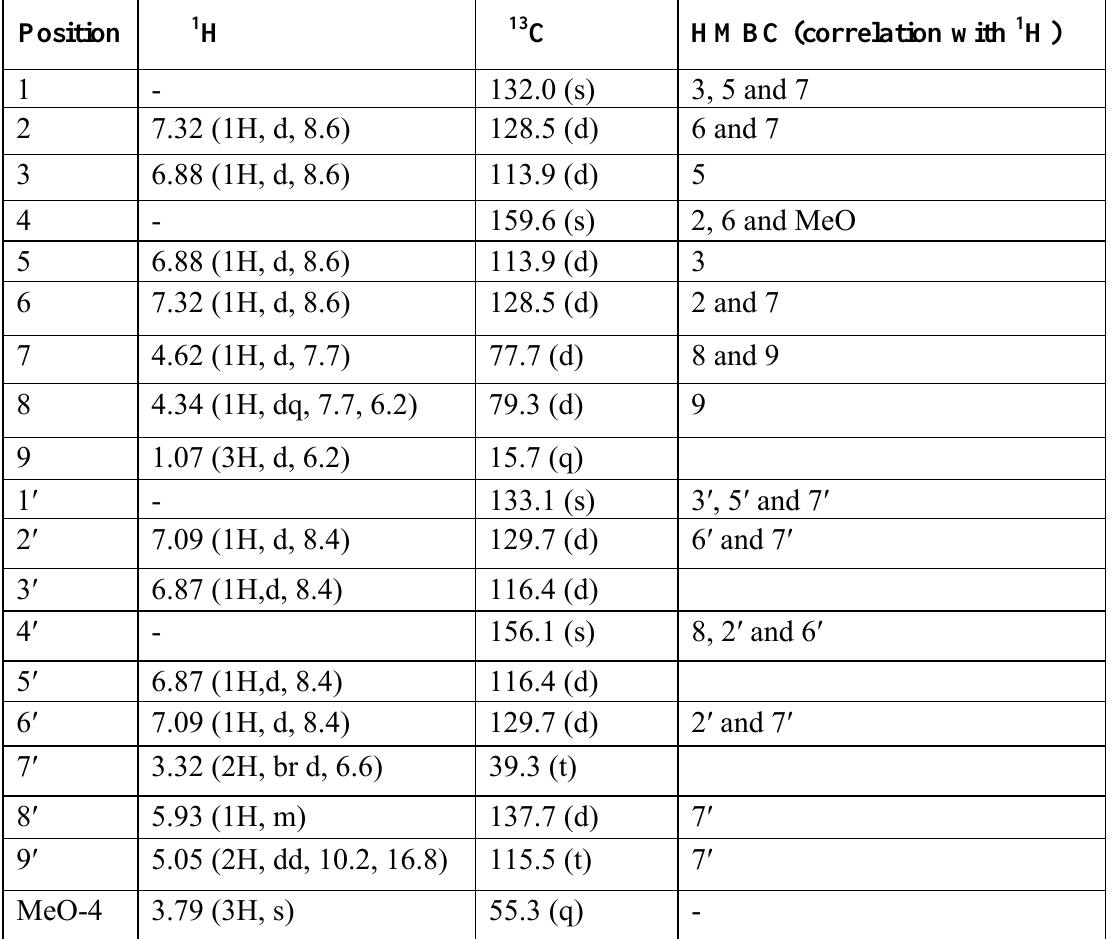
Table 1. 1 H- (300 MHz) and 13 C-NMR (75 MHz) data of 3 (CDCl and HMBC